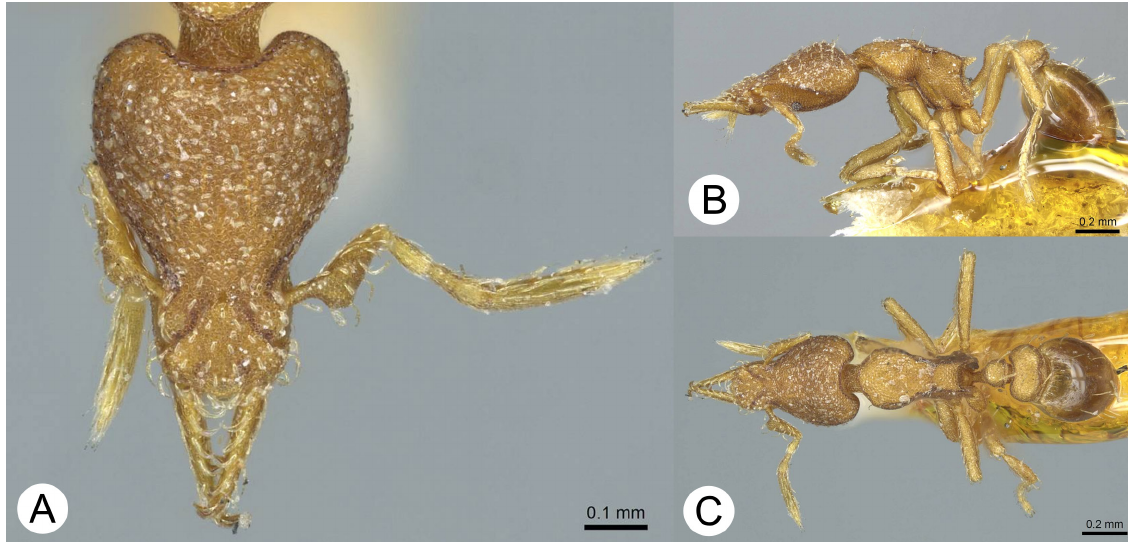
Fig. 1. Lectotype of Strumigenys crassicornis Mayr, 1887 (CC-BY, CASENT0915943, Anna Pal,